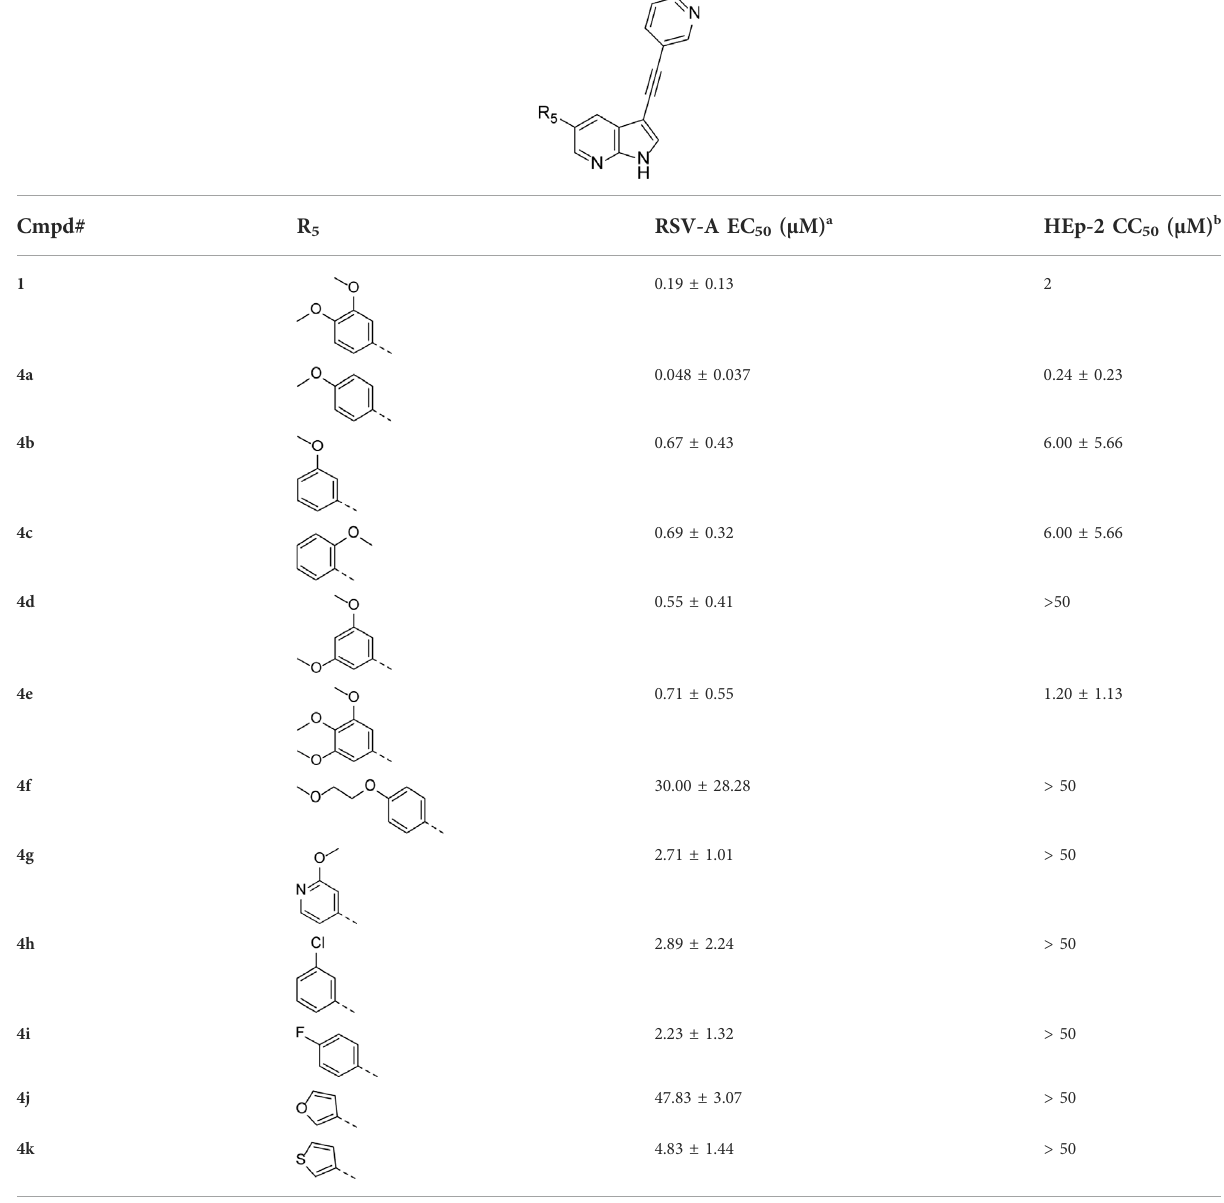
TABLE 2 Anti-RSV activity and cytotoxicity of 5-aryl-3-(pyridin-3-yl-ethynyl)-pyrrolo[2,3- b